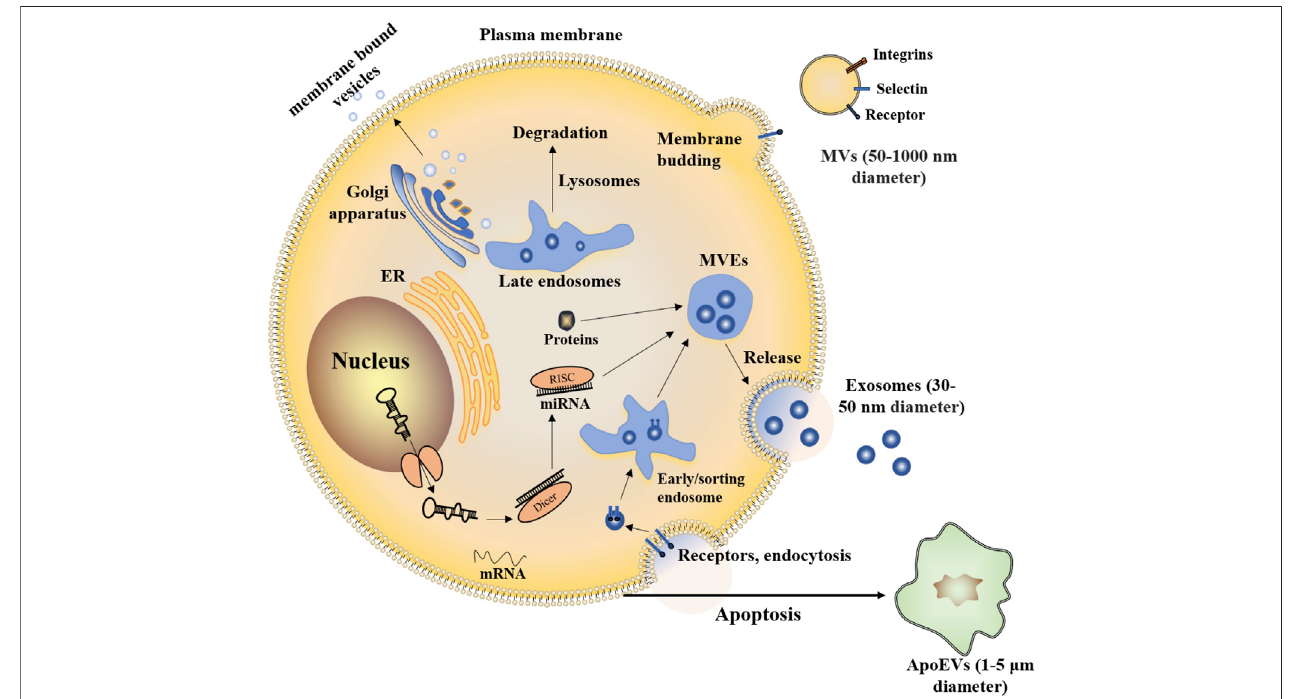
FIGURE1 | Exosomesand MVsare both released by healthy cells. Exosomesare nanometer-sized vesicles ofendocytic origin that form by inward budding ofthe limiting membrane of MVEs. MVs bud from the cell surface. Part of the endomembrane system in the cytoplasm includes the endoplasmic reticulum (ER), Golgi apparatus,andlysosomes,ithelpstopackageproteinsinsidethecellthroughmembrane-boundvesicles.Vesiclesalsoallowexchangingmembranecomponentswitha cell ’ s plasma membrane. Similar to healthy cells, apoptotic cells can also release EVs (termed apoptotic extracellular vesicles, ApoEVs).